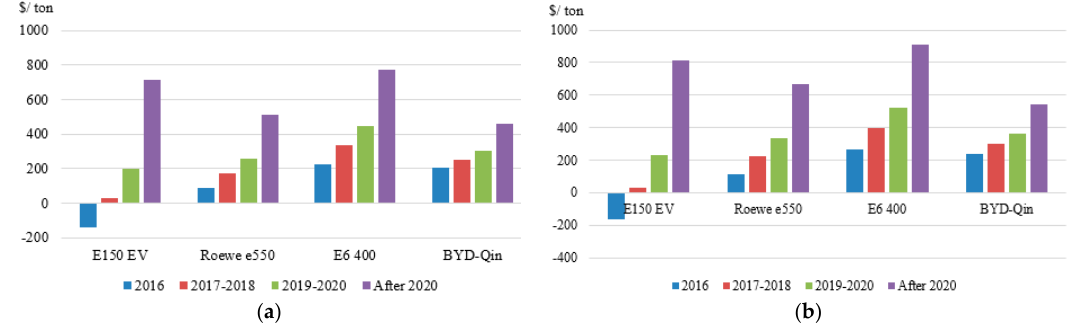
Figure 8. Cost-emission efficiency from 2016 under future government subsidy policies. ( a ) High RE scenario; ( b ) New policy scenario.